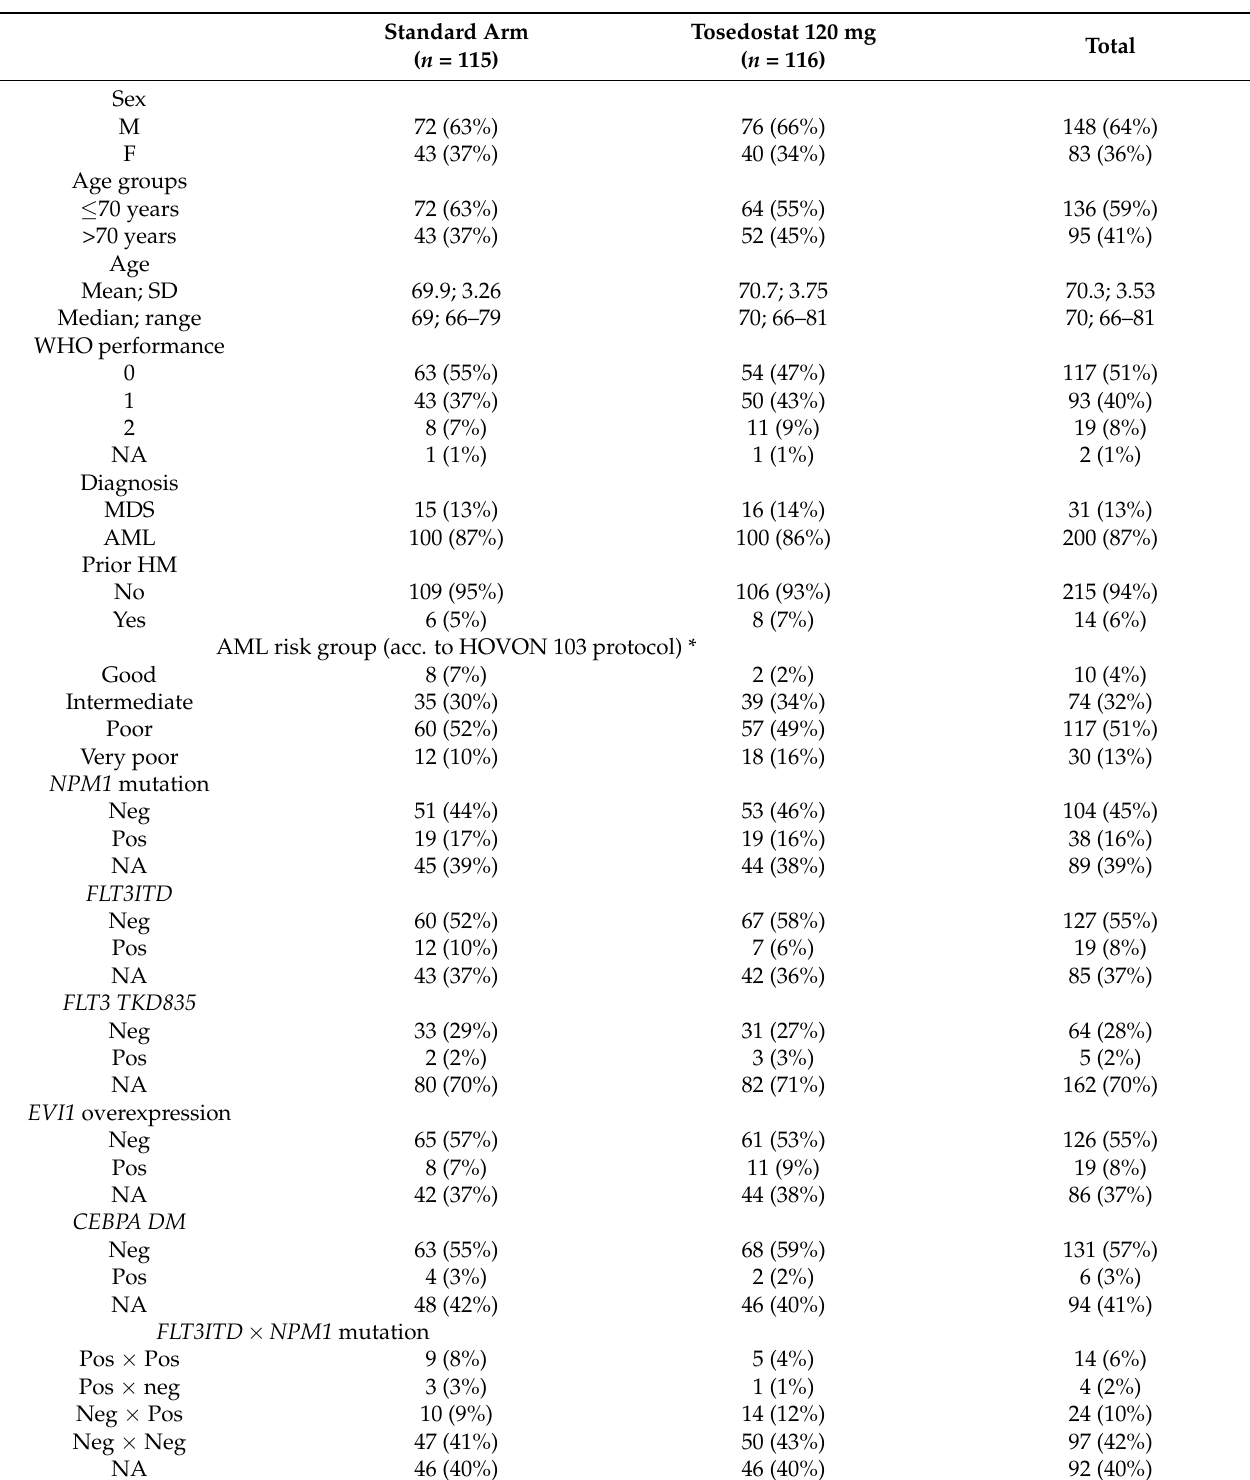
Table 1. Baseline patient